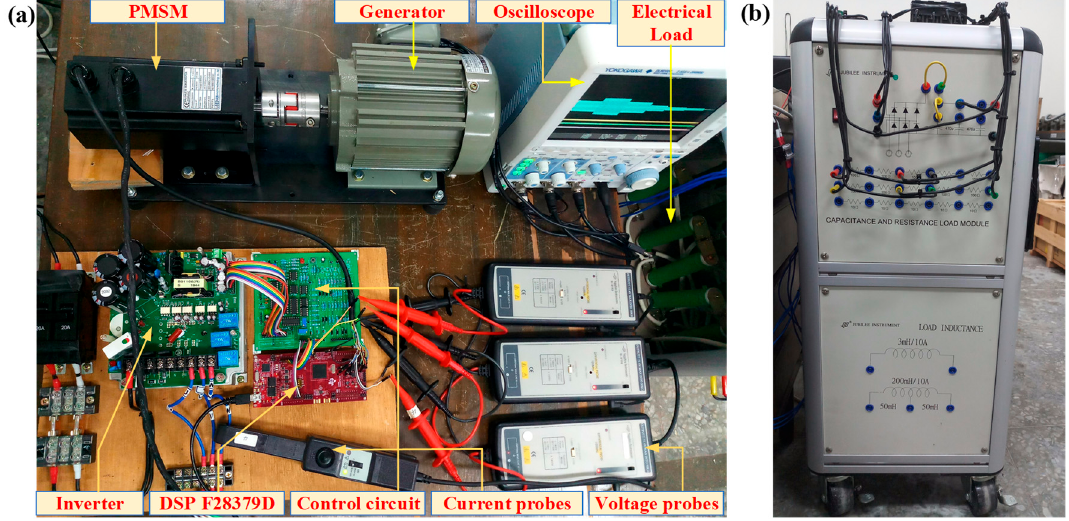
Figure 15. The experimental system with: ( a ) real platform; and ( b ) electrical load.